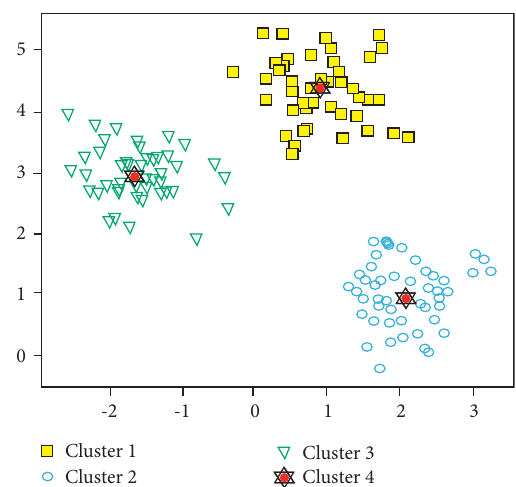
Figure 4: Clusters in the scattered plot.